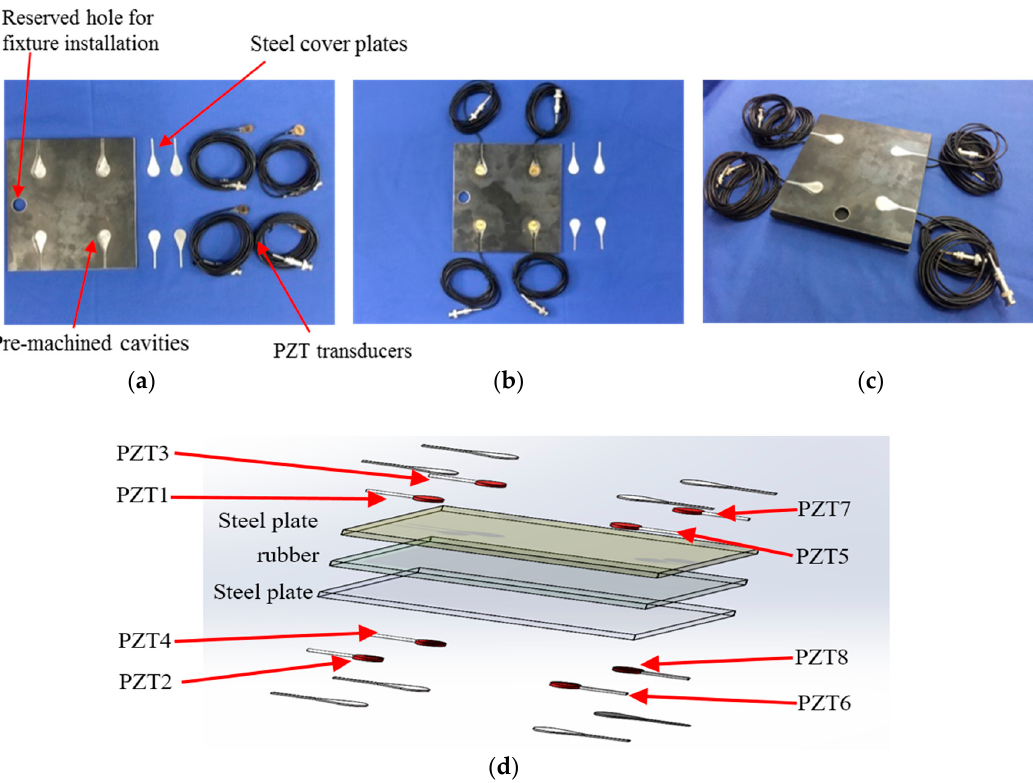
Figure 2. PZT transducer installation: ( a ) A steel plate with four pre-machined cavities; ( b ) PZT transducer installed in the cavities with epoxy; ( c ) the specimen with embedded PZT transducers; ( d ) schematic of the PZT transducer installation. Table 1. Properties for the test specimen.